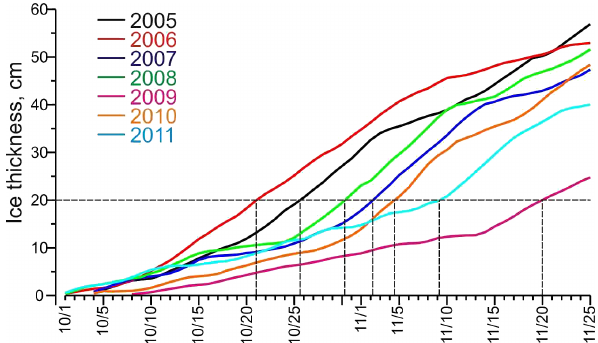
Figure 13. Time series of accumulated thermodynamic sea ice growth (cm) computed for October–November 2005–2011. Dashed lines indicate days in October–November when sea ice thickness reached 20cm.